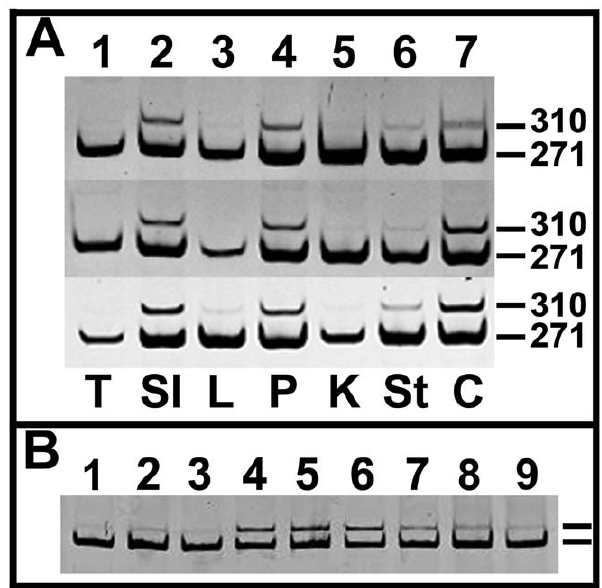
Figure 8. Cre-mediated recombination of the LSL-Kras G12D allele in different tissues. A. DNA was extracted from the indicated tissues of three different mice and subjected to 35 cycles of PCR that would detect both the wildtype Kras allele (271 bp) and the recombined LSL-Kras G12D allele (310 bp) but not the unrecombined LSL-Kras G12D allele. Tissues examined: 1) tail, 2) small intestine, 3) liver, 4) pancreas, 5) kidney, 6) stomach, and 7) colon. Strong recombined bands were detected for small intestine, pancreas and colon and weaker bands for stomach, kidney and liver, while recombination was never detected in tail DNA. B. The amount of recombination of an unaffected tissue, the small intestine, was compared to the amount in an oral papilloma in which all or nearly all of the epithelium should have a recombined Kras allele. For three different mice, DNA was prepared from total oral tissue (lanes 1–3), isolated papilloma tissue (lanes 4–6) and total small intestine tissue (lanes 7–9) and subjected to 30 cycles of PCR. Little recombination can be detected in total oral tissue while the recombination is abundant in the isolated papilloma (upper band in each lane). The amount of recombination in the small intestine was intermediate between these two populations.